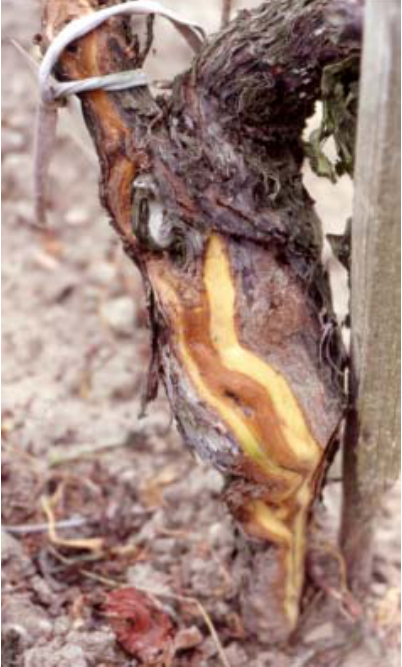
Fig. 4. Symptom in the wood. Peeling off the bark show- ing a brown